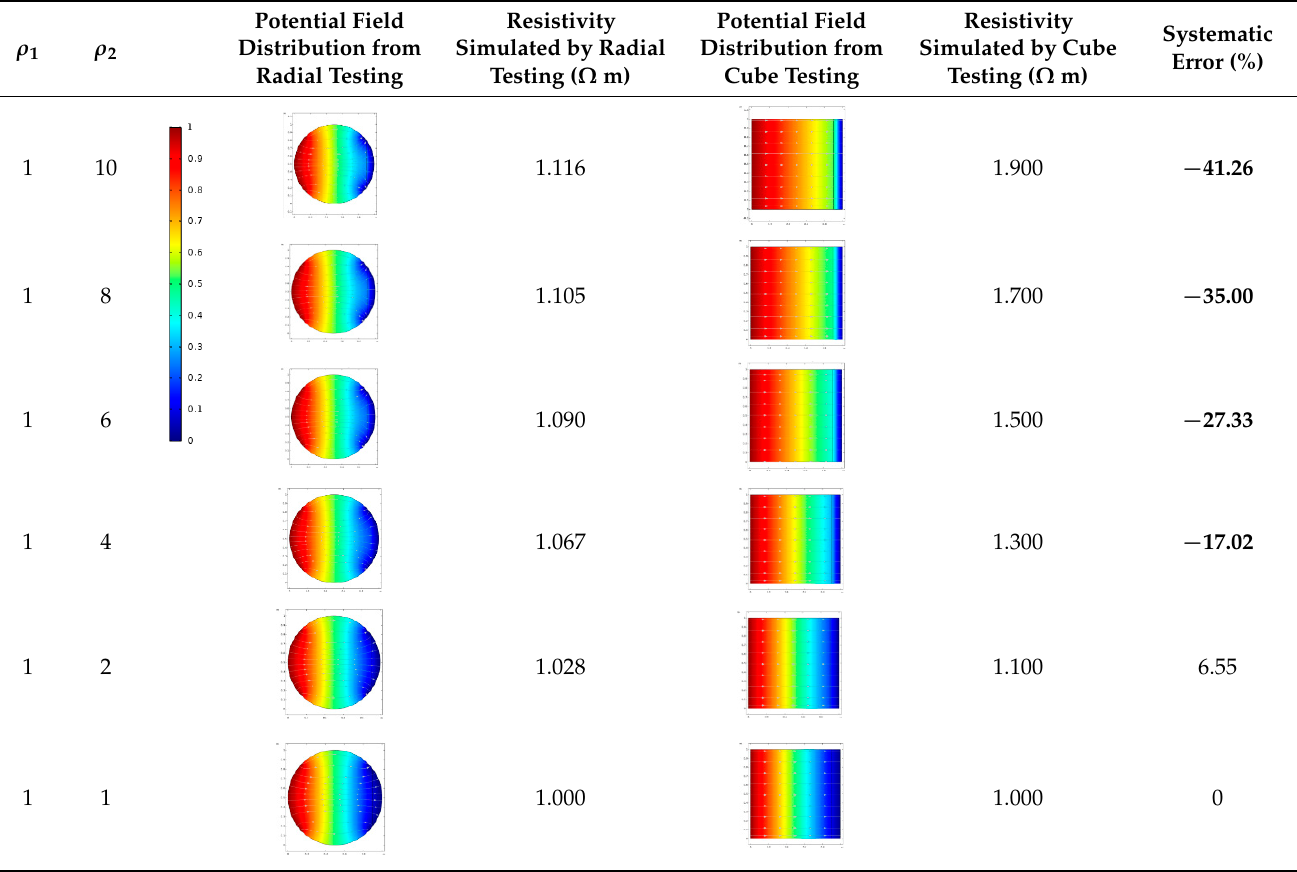
Table 9. Extreme 3: numerical simulation results for resistivity difference in various materials (0.9:0.1).